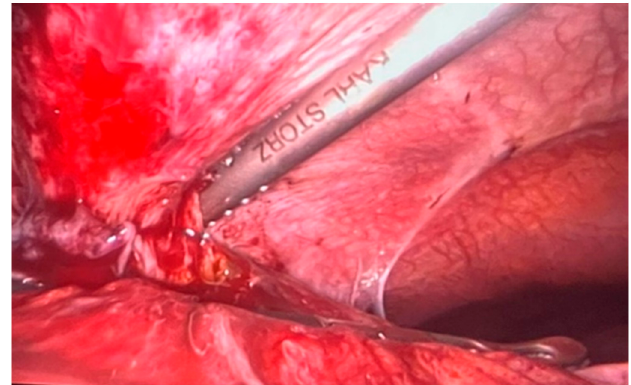
Figure 1. Dissection of the pericholecystic plastron.